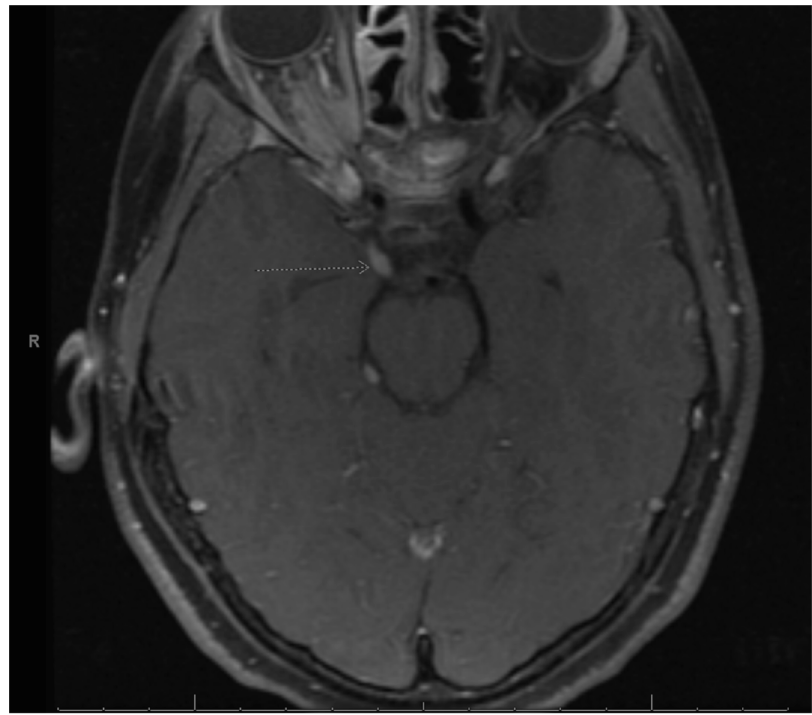
Figure 1. Right optic nerve sheath tumor. Arrow is pointing to the right optic nerve sheath tumor as stated in the figure title.